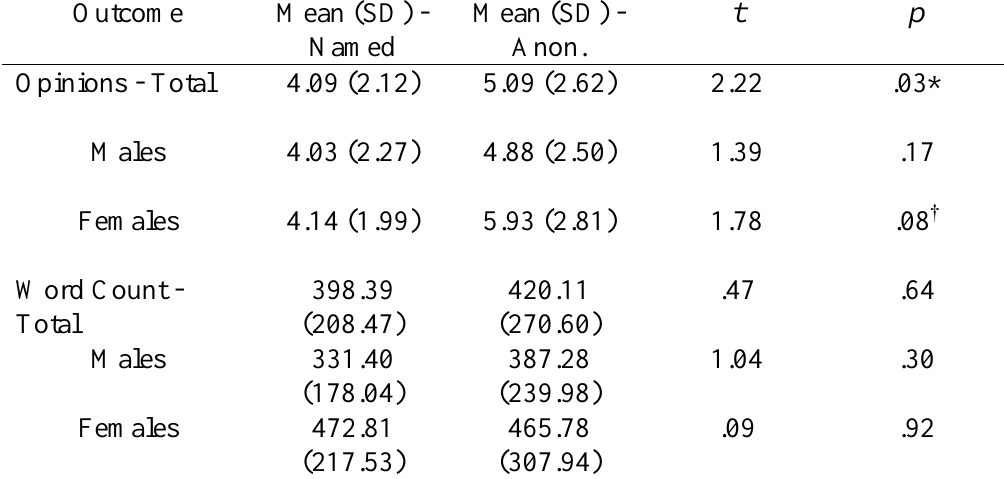
Opinion Expression and Participation in Discussion 2 Based on Condition in Discussion